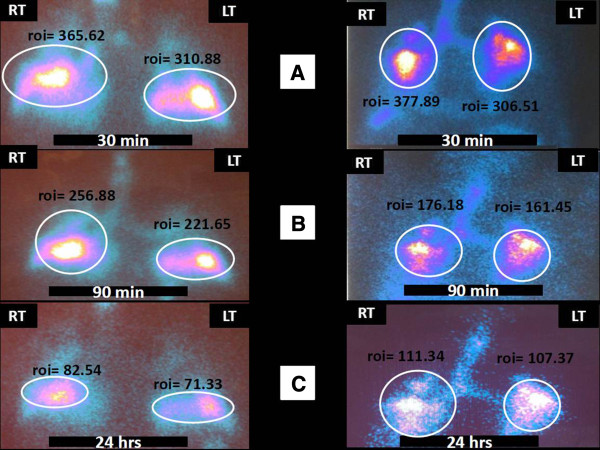
99mTc lung scintigraphy at different time points (30 min, 90 min and 24 hours) after endobronchial infusion of the adipose derived stromal cells-stromal vascular fraction (ADSCs-SVF) in two representative subjects (right and left panel, A, B and C, respectively). Retention of radiolabeled cells (99mTc-HMPAO) within both lungs was estimated with computerized image analysis by drawing regions of interest (roi) and calculating the average counts/pixels (average count). As depicted, signal intensity in both patients (right and left panel), although exhibited an expected decline through serial time-points (30 min vs. 90 min vs. 24 hours), nevertheless was present even 24 hours after the infusion. The latter evidence indicates the presence of ADSCs-SVF since free technetium (99mTcO4) has a half-time life equal to 6 hours and therefore it was impossible to produce signal 24 hours after the infusion.